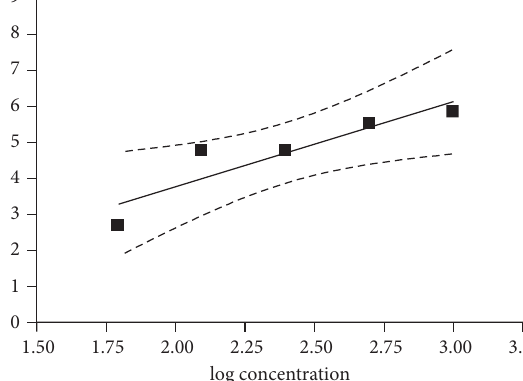
Figure 1: Dose mortality curve of R. (B.) microplus against